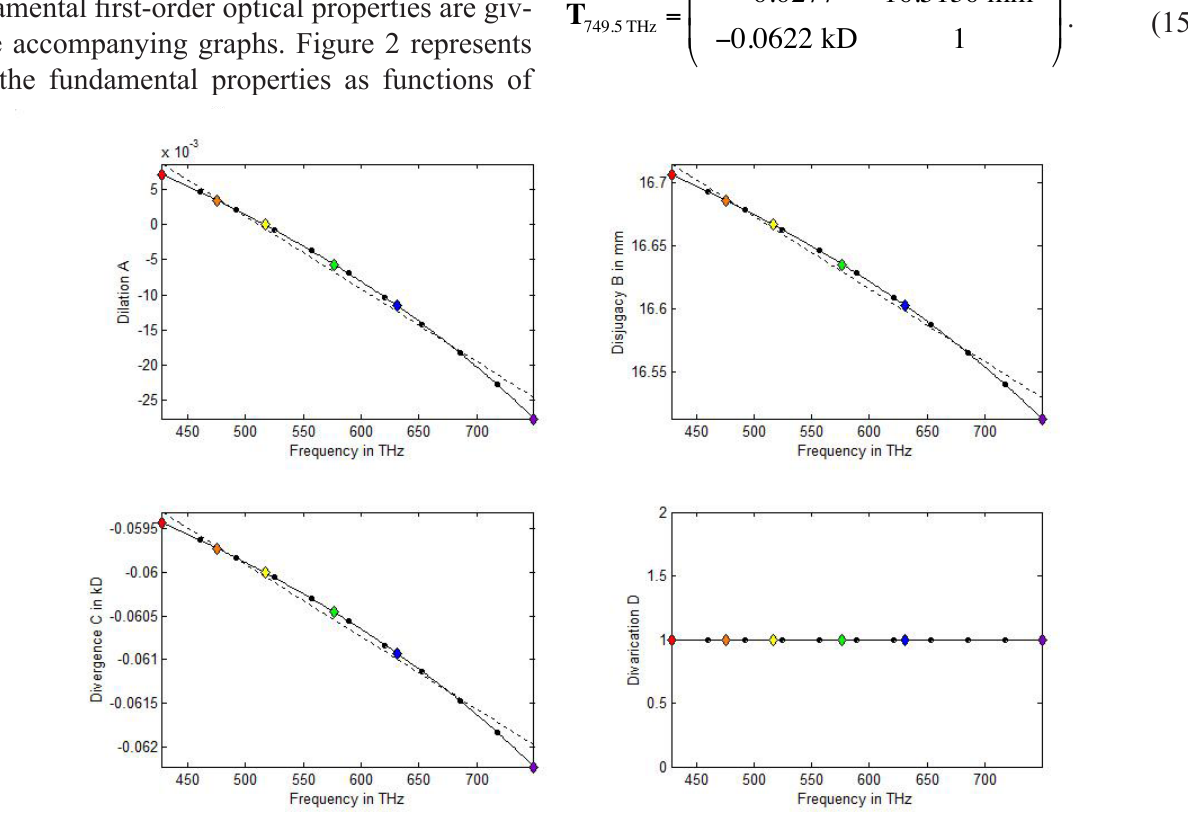
Figure 2. Sub-graphs A, B, C and D represent the four fundamental optical properties of the reduced eye as a function of frequency of light. The six coloured diamonds indicate six reference points as indicated in Table 1. The small black dots represent 10 equal intervals of 32.1 THz each. Each of A , B and C present as curves, while D is a horizontal straight line at